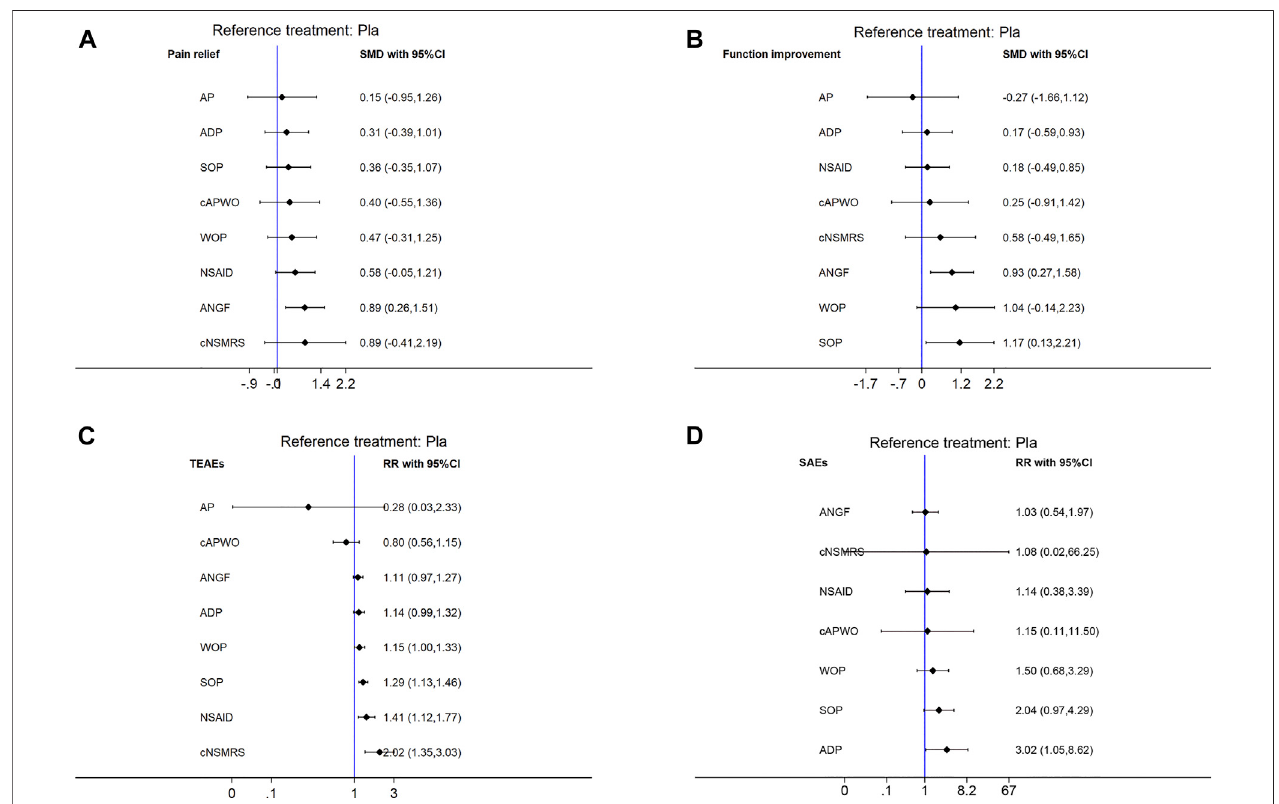
FIGURE 2 | Forest plots of main analysis. SMD: Standardized mean differences; RR: risk ratio; CI: Con fi dence intervals. Differences between treatments were considered signi fi cantwhen the95% CIdid not contain 1for RRs or 0for SMDs. An intervention would be considered as aprotectivefactor when its SMD less than 0 or RR less than 1, otherwise it would be risk factor. (A) Pain relief. (B) Function improvement. (C) TEAEs. (D) SAEs. Reference to